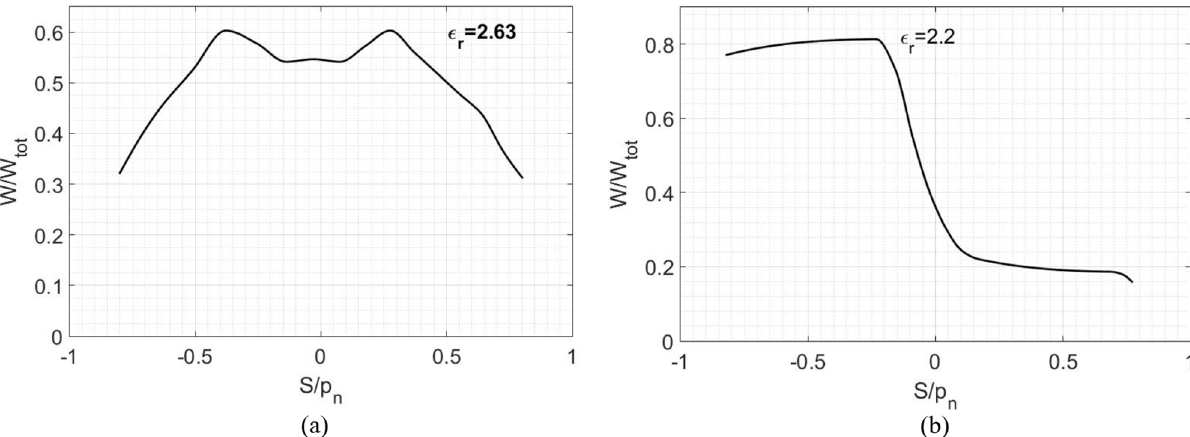
Fig. 15. Load sharing for the 25/25 plastic gear pair and the 20/30 plastic/steel gear pair for different contact